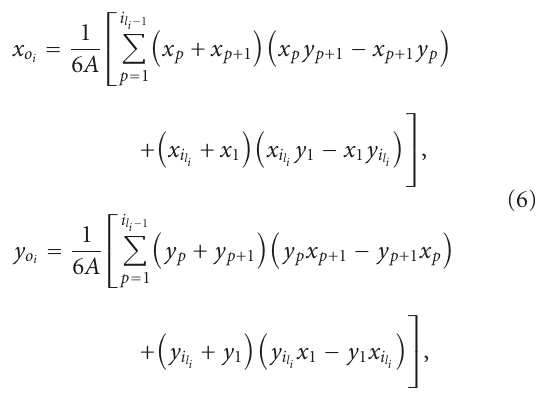
are 1 , f 2 , f 3 . 1 , f 2 , f 3